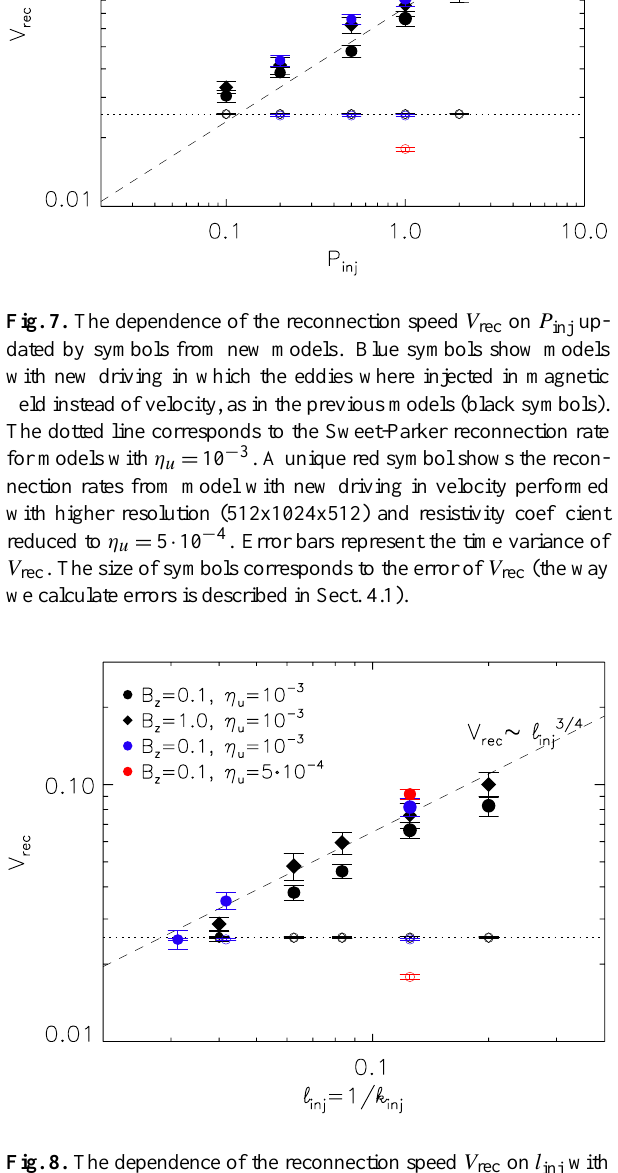
Fig. 8. The dependence of the reconnection speed V rec on l inj with additional models in which turbulence was driven in a new way, as described in Sect. 3.4. Similarly to Fig. 7, blue symbols show models with perturbed magnetic field, and red symbols correspond to a high resolution model with reduced uniform resistivity in which turbulence was driven in velocity. The dotted line corresponds to the Sweet-Parker reconnection rate for models with η u = 10 − 3 . Error bars and the size of symbols have the same meaning as in Fig. 7.